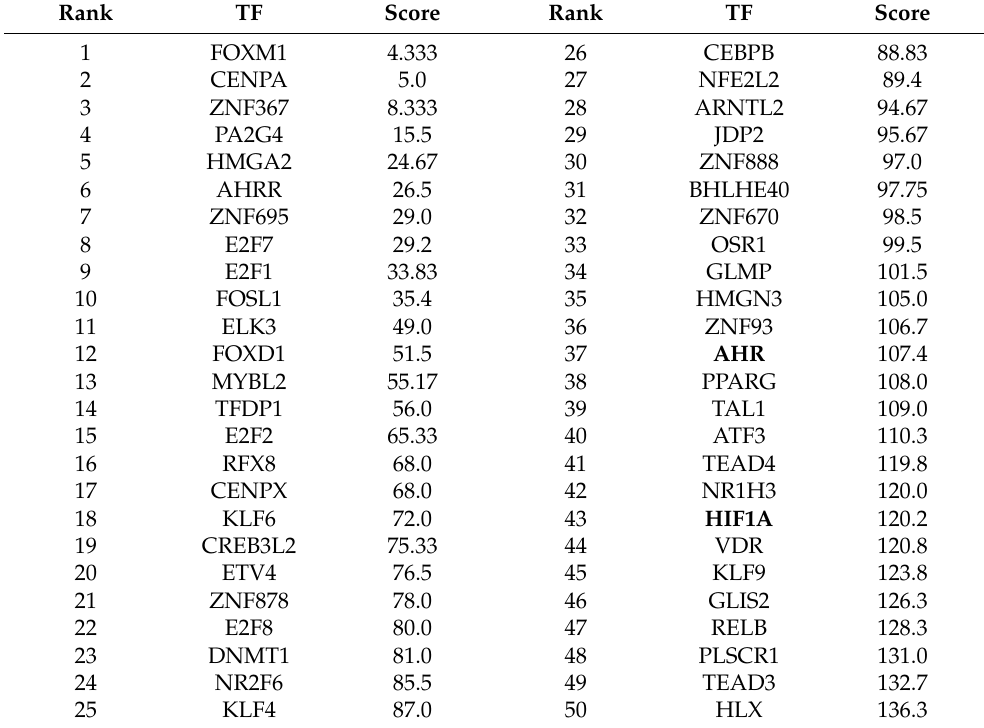
Table 2. Top50 ranking of transcription factors whose putative transcriptional targets are most closely similar to those in the query set. CHEA3 results for transcription factors enrichment analysis (TFEA). Lower scores indicate more relevancy to the related transcription factor. Full query = 1632